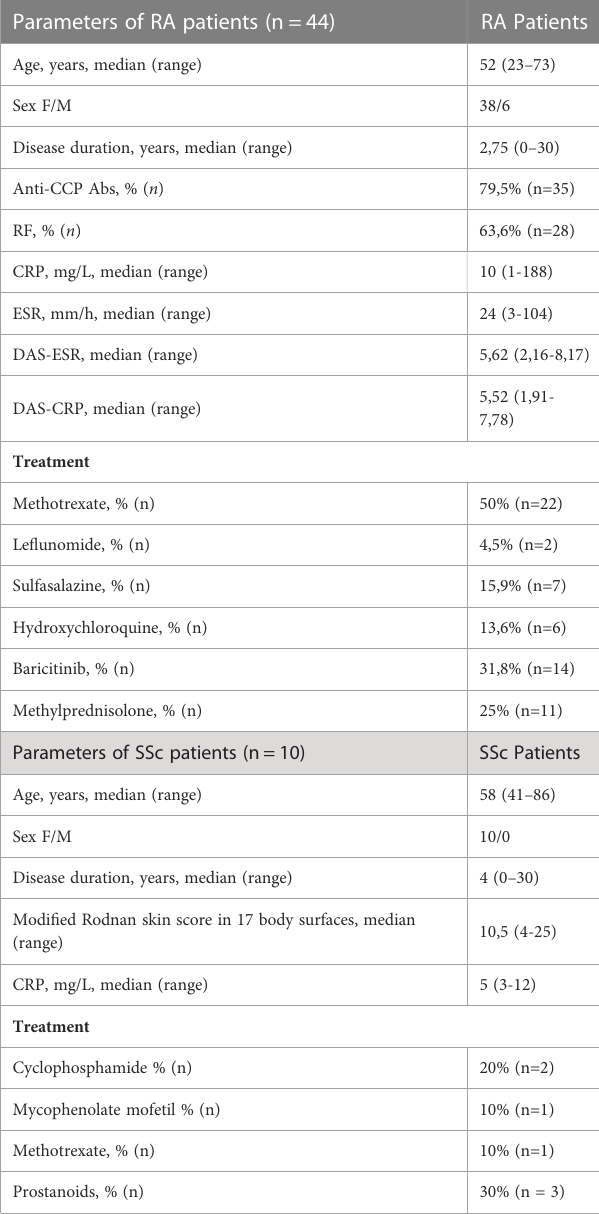
TABLE 1 Clinical and laboratory data of RA and SSc